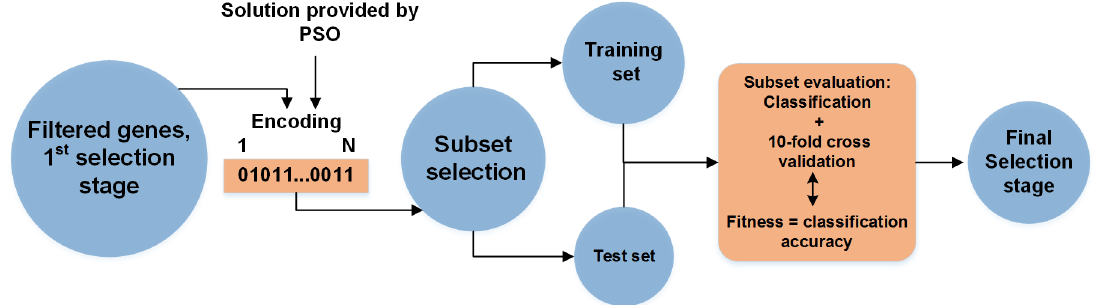
Fig 3. Application of GBPSO-SVM in gene selection.